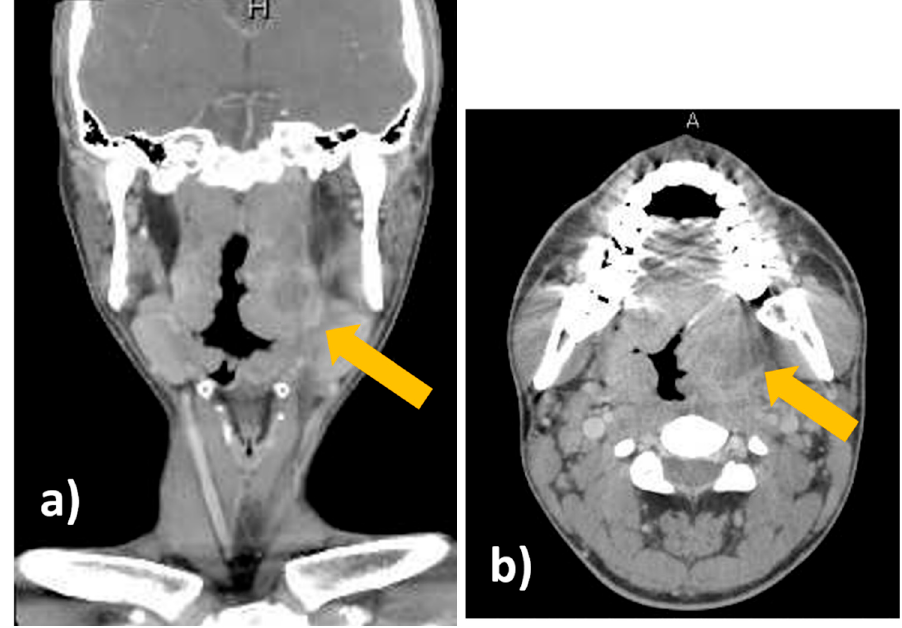
Figure 1. Contrast-enhanced computed tomography. ( a ) Coronal view. ( b ) Axial view. The peritonsillar abscess is indicated by the yellow arrows.